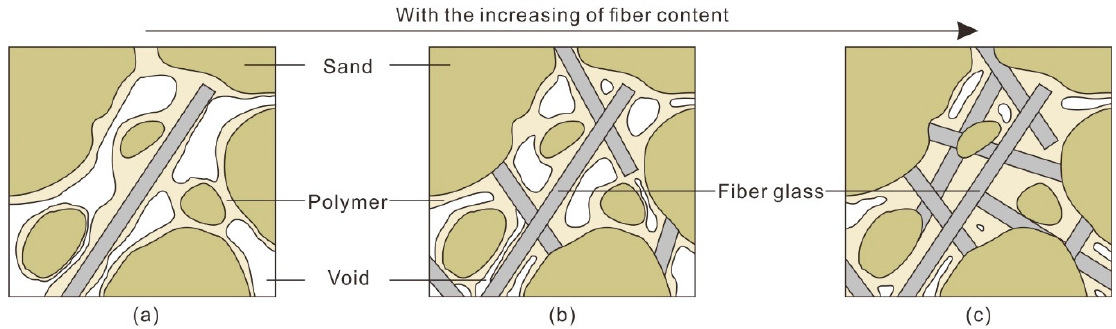
Figure 16. Schematic drawing of the microstructure of reinforced sand at different fiber contents. ( a ) Low fiber content; ( b ) Medium fiber content; ( c ) High fiber content.